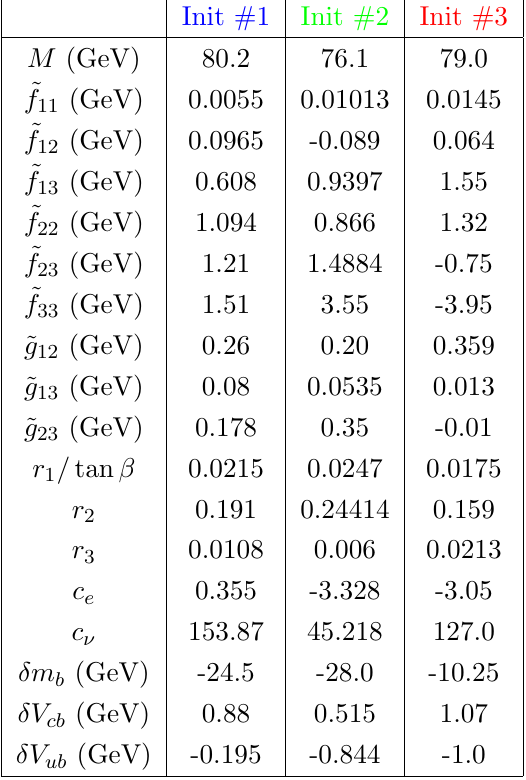
Table 2 . Initial values for the model input parameters at the GUT scale with type-I seesaw. Label colors correspond to those in the plots to